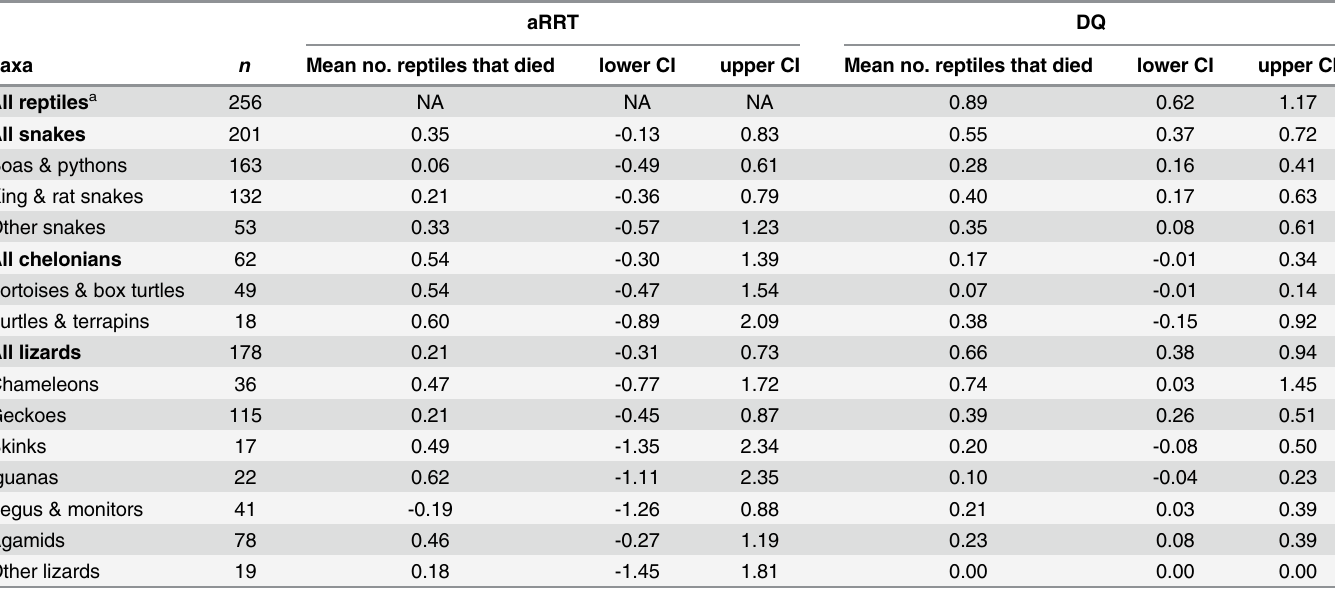
Table 2. Bootstrapped mean number of reptiles that died within a year of acquisition, over five years preceding the study, including 95% confi- dence intervals, estimated for additive (aRRT) and direct questions (DQ) via 1000 bootstrap